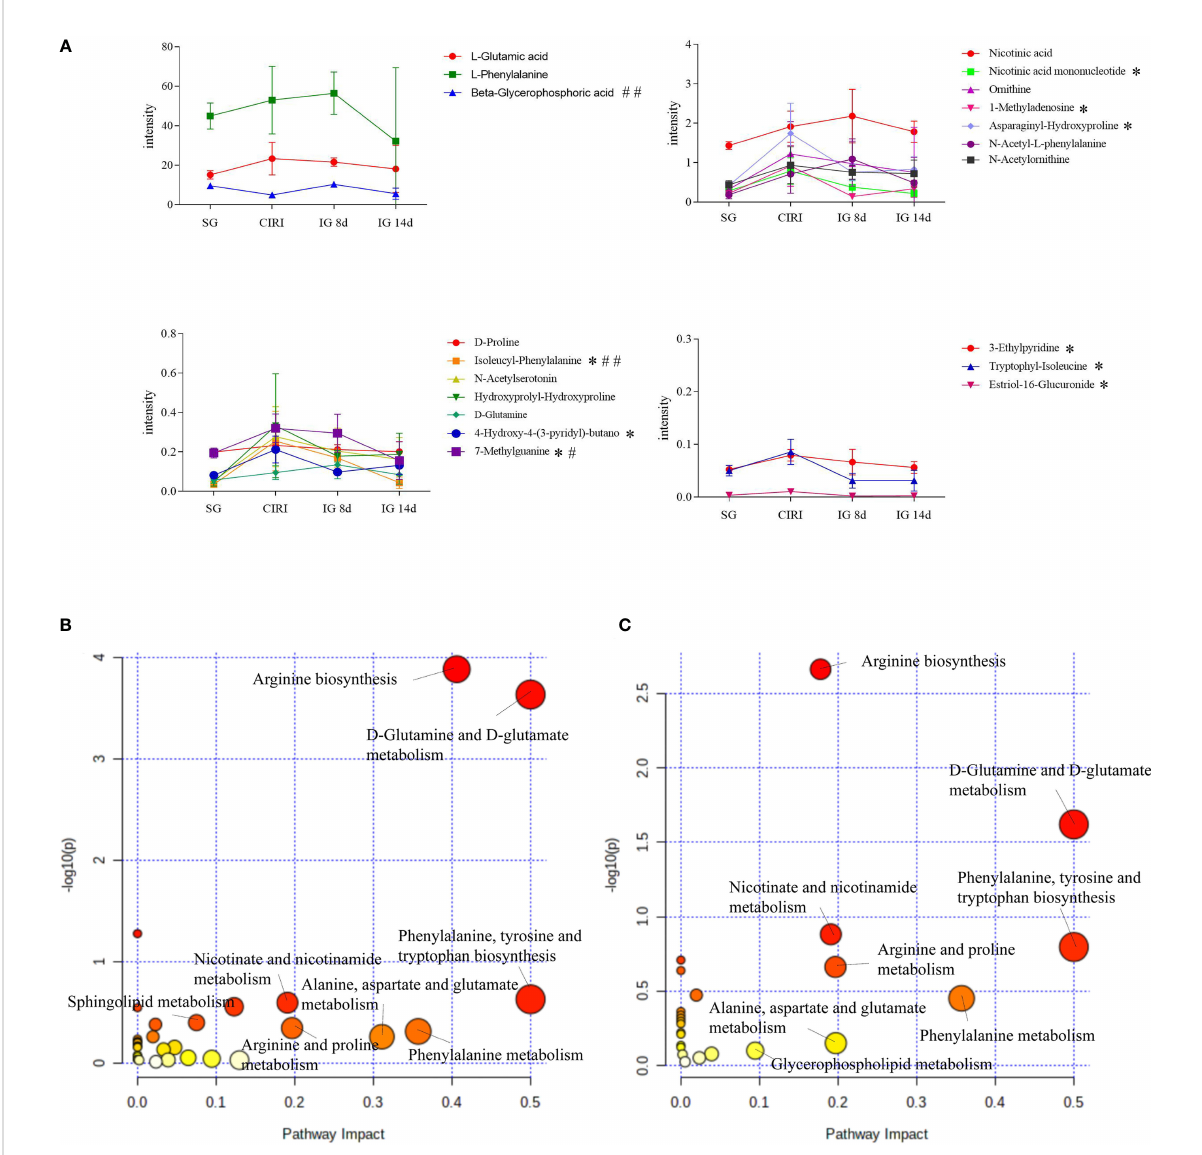
FIGURE 10 Expression levels of differentially expressed metabolites in the serum in the SG, CIRI, IG 8d, and IG 14d groups (A) and affected metabolic pathways. Diagram of the abnormal metabolic pathways in CIRI rats (B) . Diagram of the metabolic pathways of Gastrodia elata Blume callback (C) . * P < 0.05 when IG 14d was compared with the CIRI; # P < 0.05, ## P < 0.01when IG 14d was compared with the IG 8d in (A)